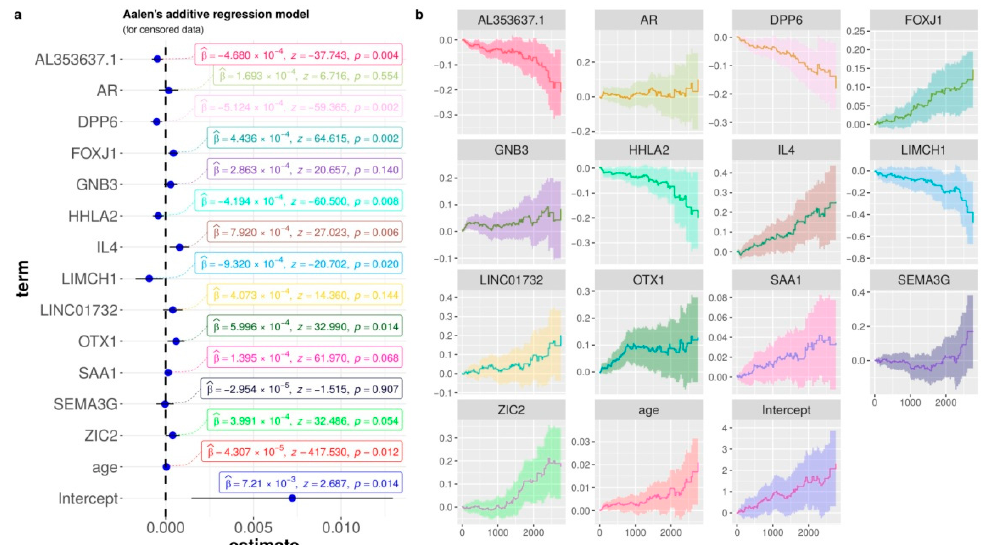
Figure 5. Aalen’s additive Cox regression model for censored data of the mRMR signature, and the clinical features age and metastasis. ( a ) The dot-and-whisker plots with the estimated coefficients ( β ), z-score, their confidence intervals (95%), and the p -values. ( b ) Curves of each term for the censored data in relation to time (days).